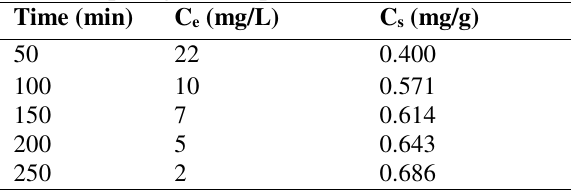
Kinetics data for the sorption of Cr(III) onto ZVAI/ZVI mixture at optimum pH 5.5,250 min contact time,50 mg/L initial metal concentration, and 250 rpm agitation speed.